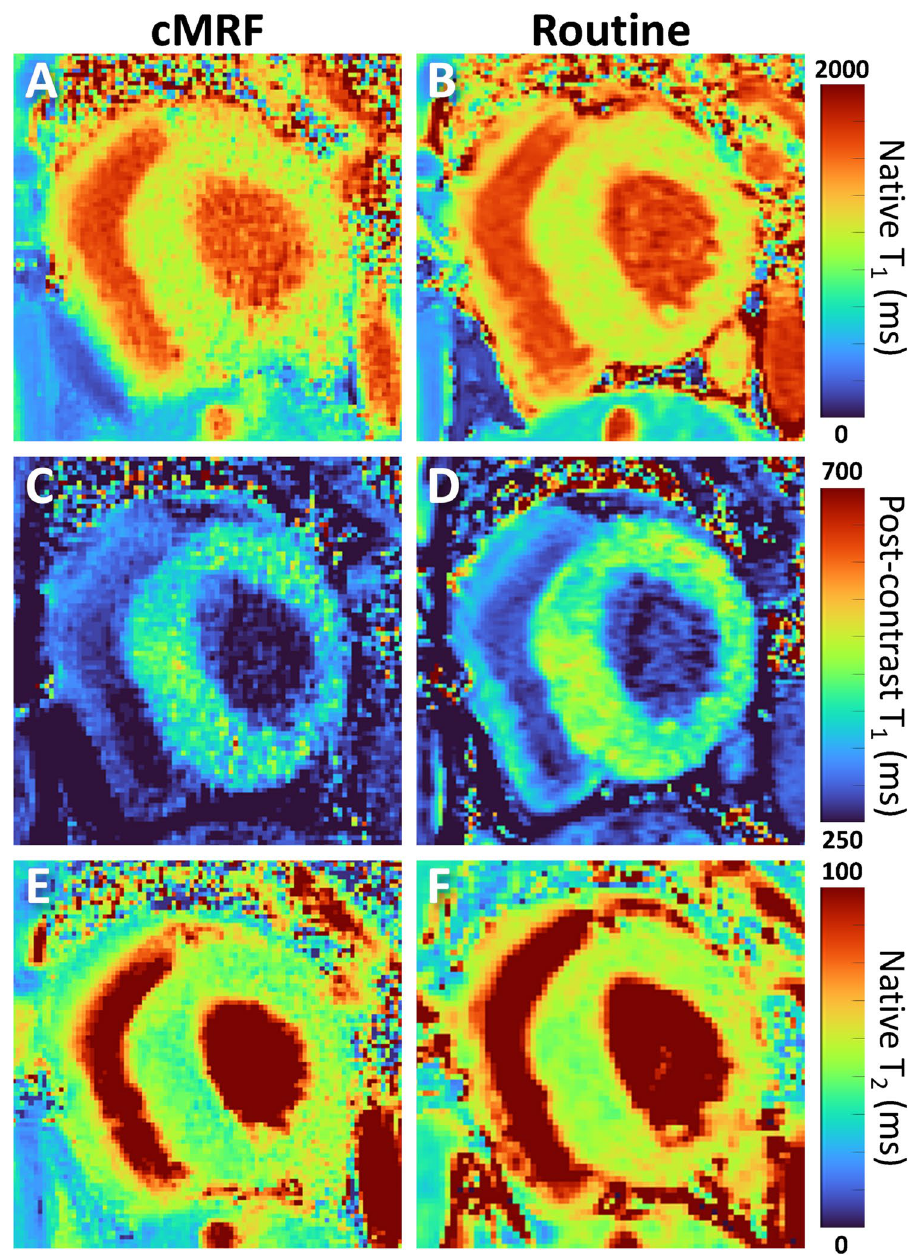
Figure 4. Respiratory drift resulted in noisier cMRF T 1 and T 2 maps in a 35 y.o. patient with hypertrophic CMP. The patient did not comply with the breath holding protocol and slowly breathed out during several acquisitions. ( A , B ) T 1 maps before contrast agent injection. The patient complied with the very first breath hold (the routine T 1 map), but not the subsequent cMRF: its T 1 map appears noisy and its borders are poorly defined. The myocardial T 1 values are 1079 ± 99 ms for cMRF and 1119 ± 69 ms for MOLLI. ( C , D ) T 1 maps 20–25 min after contrast agent injection. Despite some respiratory drift, the routine T 1 map source images were correctly aligned during registration and resulted in a precise map. Also note the higher T 1 values in the myocardium of the routine map (404 ± 39 ms for cMRF and 447 ± 29 ms for MOLLI). ( E , F ) Native T 2 maps. Slightly higher regional variability can be observed in the routine map, and the total myocardial area appears smaller due to poor registration of the source images. The averages across the myocardium were 46 ± 5 ms for cMRF and 51 ± 5 ms for T 2